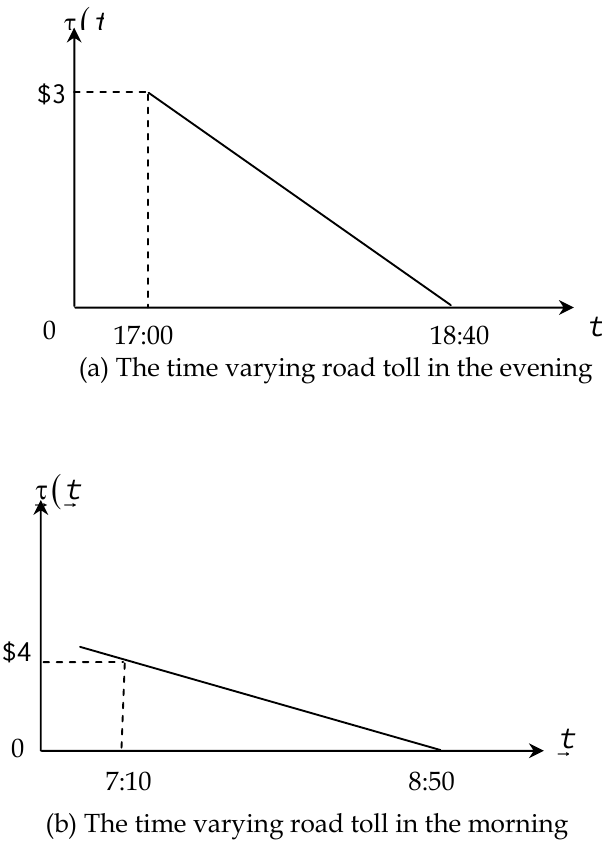
Figure 6. Time-varying road tolls in regime